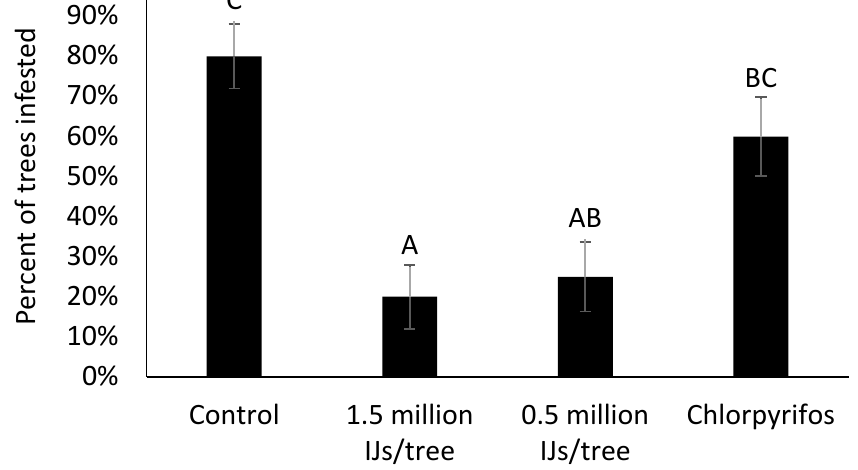
Figure 2. Percentage of peach trees infested with peachtree borers in 2019. Control = no nematodes applied, IJs = infective juveniles. The application was made in a conventional peach orchard in fall 2018 with a reapplication and assessment in spring 2019. Different letters above bars indicate significant differences ( p < 0.05).